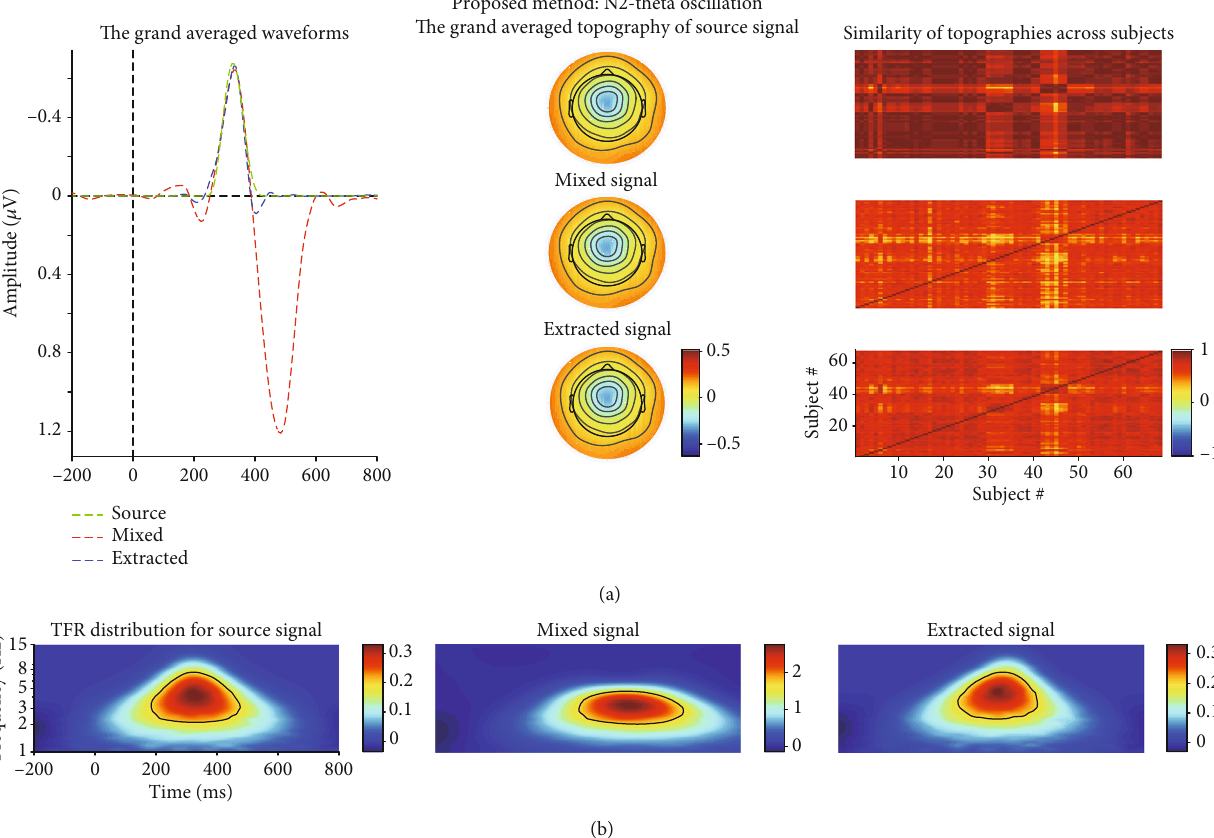
Figure 3: (a) The grand averaged waveform at FCz electrode, topography (the time window was from 300 to 400 ms), and similarity of topographies among subjects of the source/mixed/extracted N2 for the synthetic dataset when SNR is equal to 10 dB. (b) The associated grand averaged time-frequency representations (TFRs) at FCz of the source, mixed, and extracted (using the proposed approach) signals for N2-theta oscillation separately. The mixed signal plays the role of the preprocessed ERPs with the consideration of a real ERP